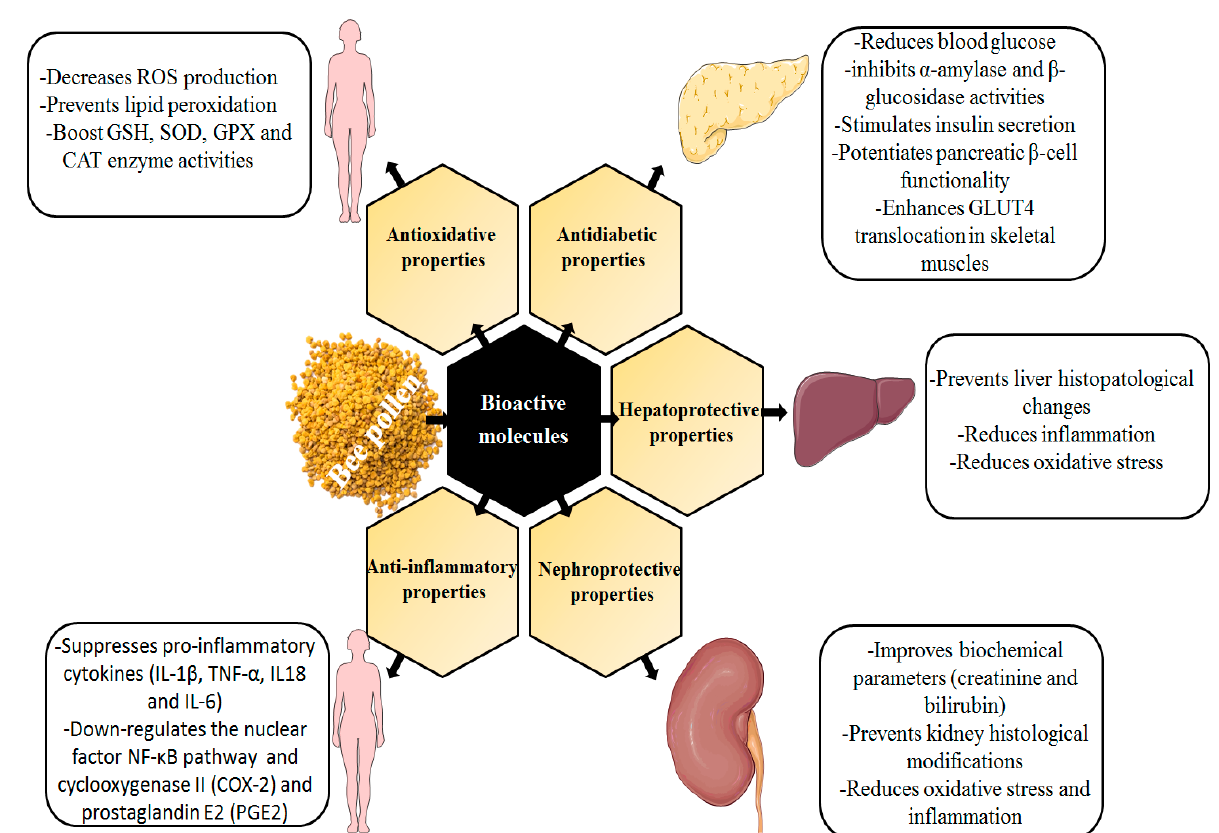
Figure 1. Schematic presentation of the therapeutic properties of bee pollen .